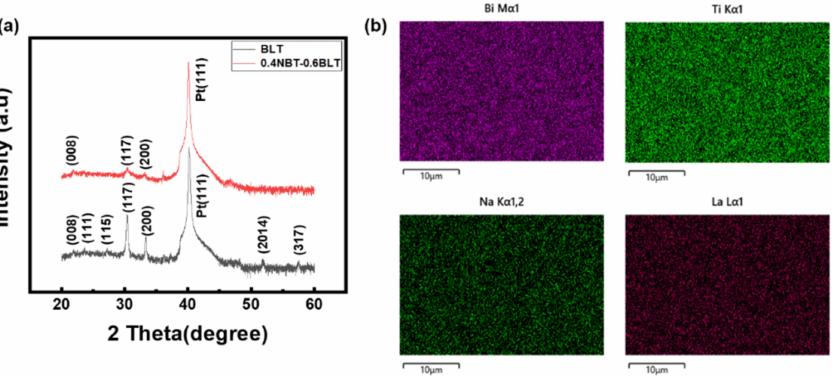
Figure 1. ( a ) XRD patterns of BLT and BNT-BLT. ( b ) EDS spectrum of